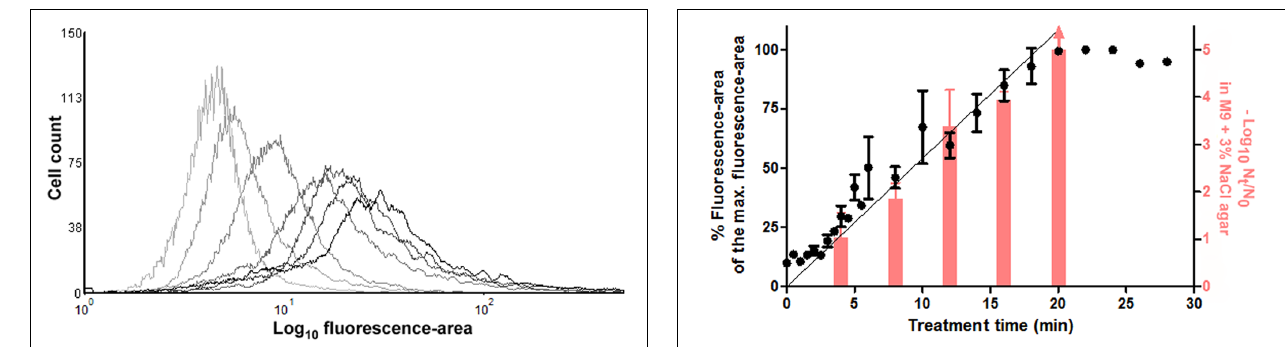
FIGURE 7 | Fluorescence histogram overlays obtained by flow cytometry measurement of PI-stained E. coli BW25113 cells of untreated cells and after thermal treatments at 53 ◦ C. Each overlay represents the frequency distribution of the fluorescence intensity (fluorescence-area values) of a total of 10000 events per sample, corresponding to the untreated sample (lighter overlay), or samples treated for 2, 4, 6, 10, 16, or 20 (darker overlay) min. Results shown from a representative experiment repeated three times with similar results.